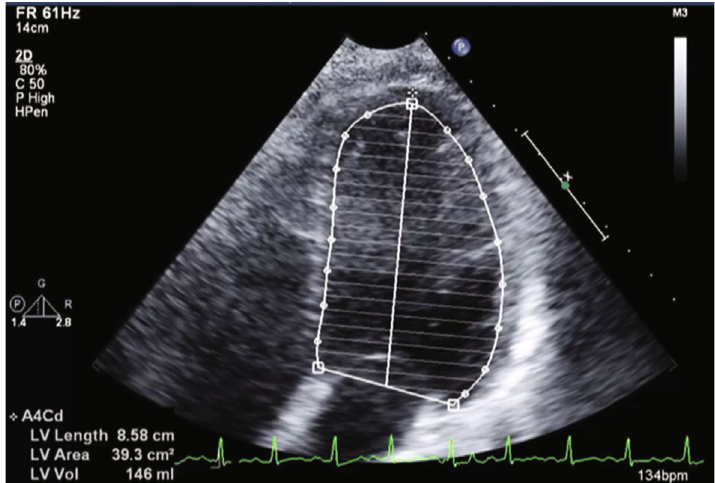
Figure 3: Simpson ’ s method of disc ’ s for measuring ejection fraction at the end of diastole on admission.